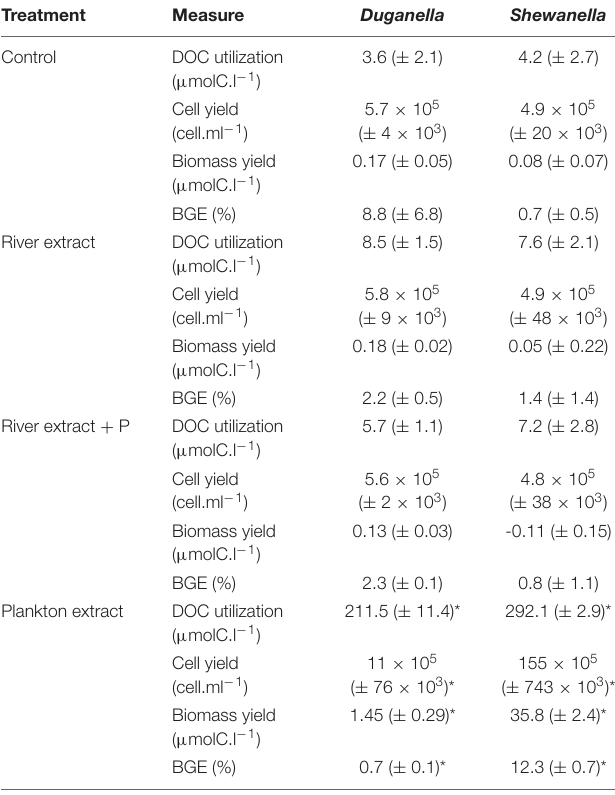
TABLE 2 | Comparison of the DOC utilization, cell yield, carbon biomass yield, and growth efficiency (BGE) of the Duganella and the Shewanella bacterium in the Control, River extract, River extract + P and Plankton extract incubations in the microcosm experiment.